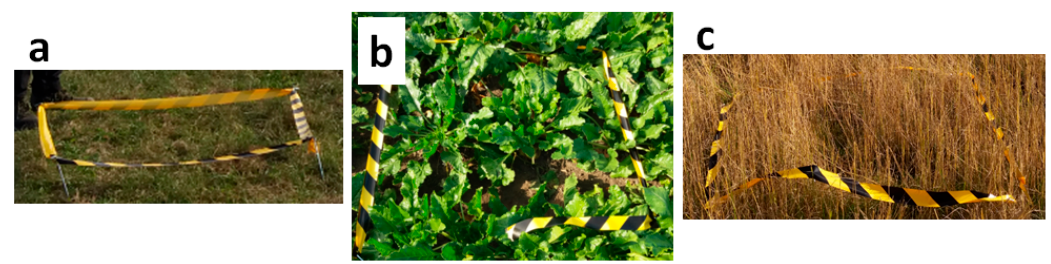
Table 3. Overview of the spectral field plots.